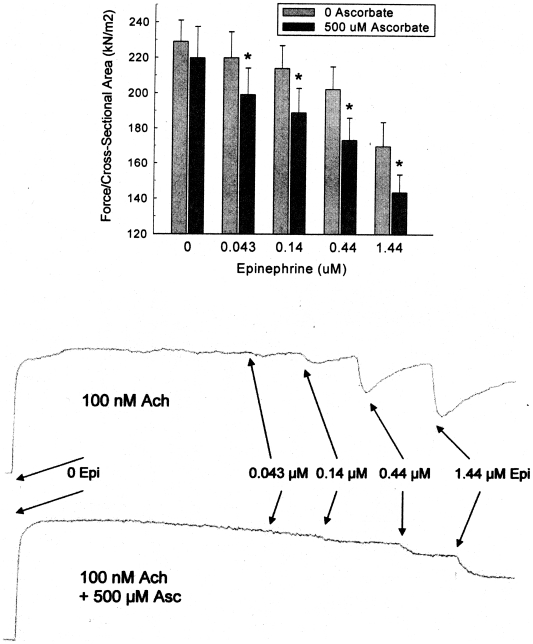
Top: Effect of 500 µM ascorbate on cumulative epinephrine relaxation (1 µM Epi) of 1 µM Ach contractions of porcine trachealis at ten minutes following each Epi addition.Values are mean ± SE. N = 4. The * indicates a significant difference (p<0.05) from the 0 Asc data. Bottom: Typical chart recordings showing the effect of of 500 µM ascorbate on cumulative epinephrine relaxation (1 µM Epi) of 1 µM Ach contractions of porcine trachealis. Asc not only increases the duration of relaxation, but also blunts the acute effects of each cumulative dose (perhaps because Asc binds to Epi [3], [23], [24], modulating its availability to the receptor).